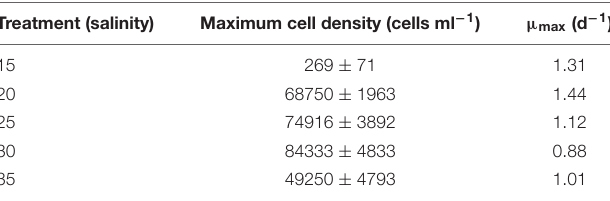
TABLE 1 | Growth parameters of Pseudochattonella verruculosa cultures (mean ± SD) maximum cell density and µ max mean maximum specific growth rate and under five different salinity